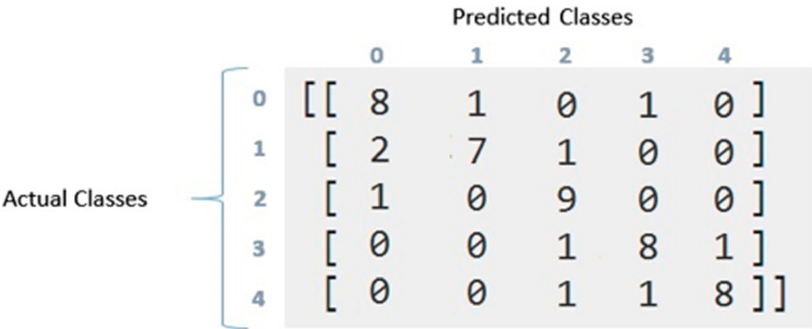
Figure 10. Confusion matrix of dataset. Class 0, 1, 2, 3, and 4 stand for ‘No SAD’, Marked, Moderate, Severe, and Very Severe groups, respectively. Table 5. Recall, precision score of SAD